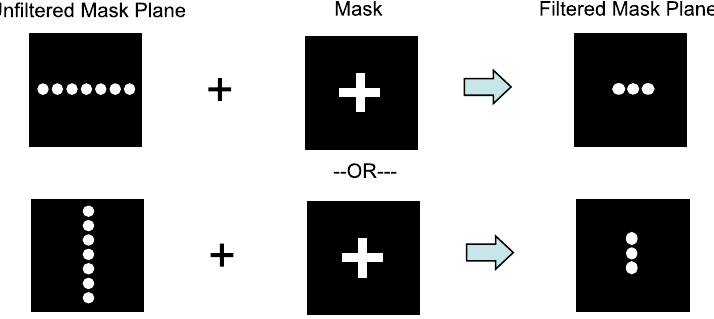
FIG. 7. Continued example of exam problem covering Fourier